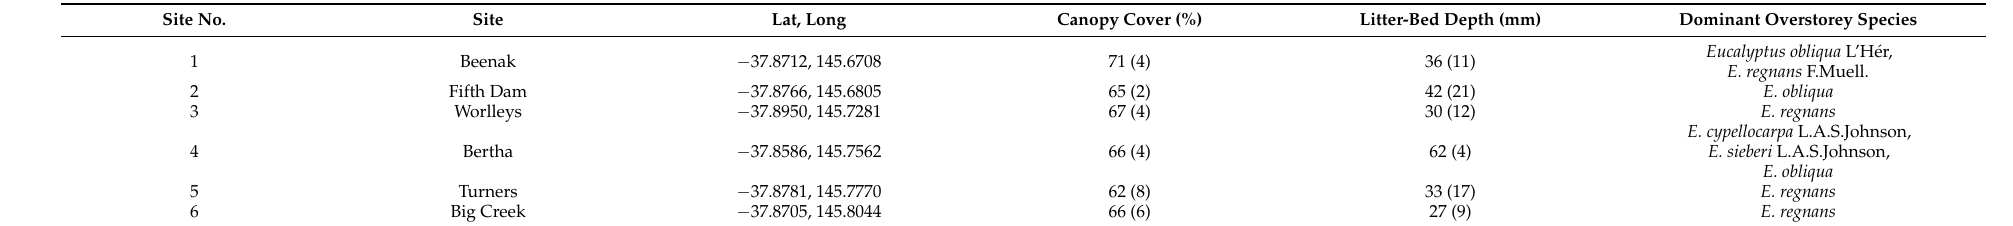
Table A2. Site attributes. Means (with standard deviation in parentheses) reported for canopy cover and litter-bed depth. Site